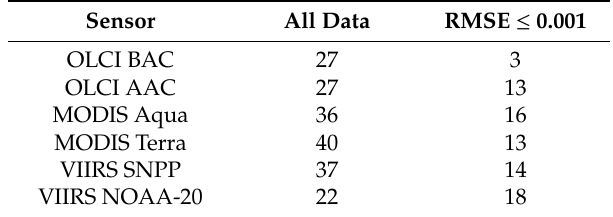
Figure 11. Average RMSE values obtained by comparing shipboard and satellite data for 15 ship stations and 27 OLCI spectra calculated using the C2RCC processor, depending on the solar zenith angle (left), observation zenith angle (center), and the absolute values of azimuth angle differences (right). Gray circles indicate the cloud risk flag, red asterisks—glint risk, black crosses—any other flag, colored circles—data without flags. Table 5. The total number of satellite data points for 15 stations with shipboard reflectance measurements and their number with RMSE ≤ 0.001. AAC — Alternative Atmospheric Correction, BAC — Baseline Atmospheric Correction.